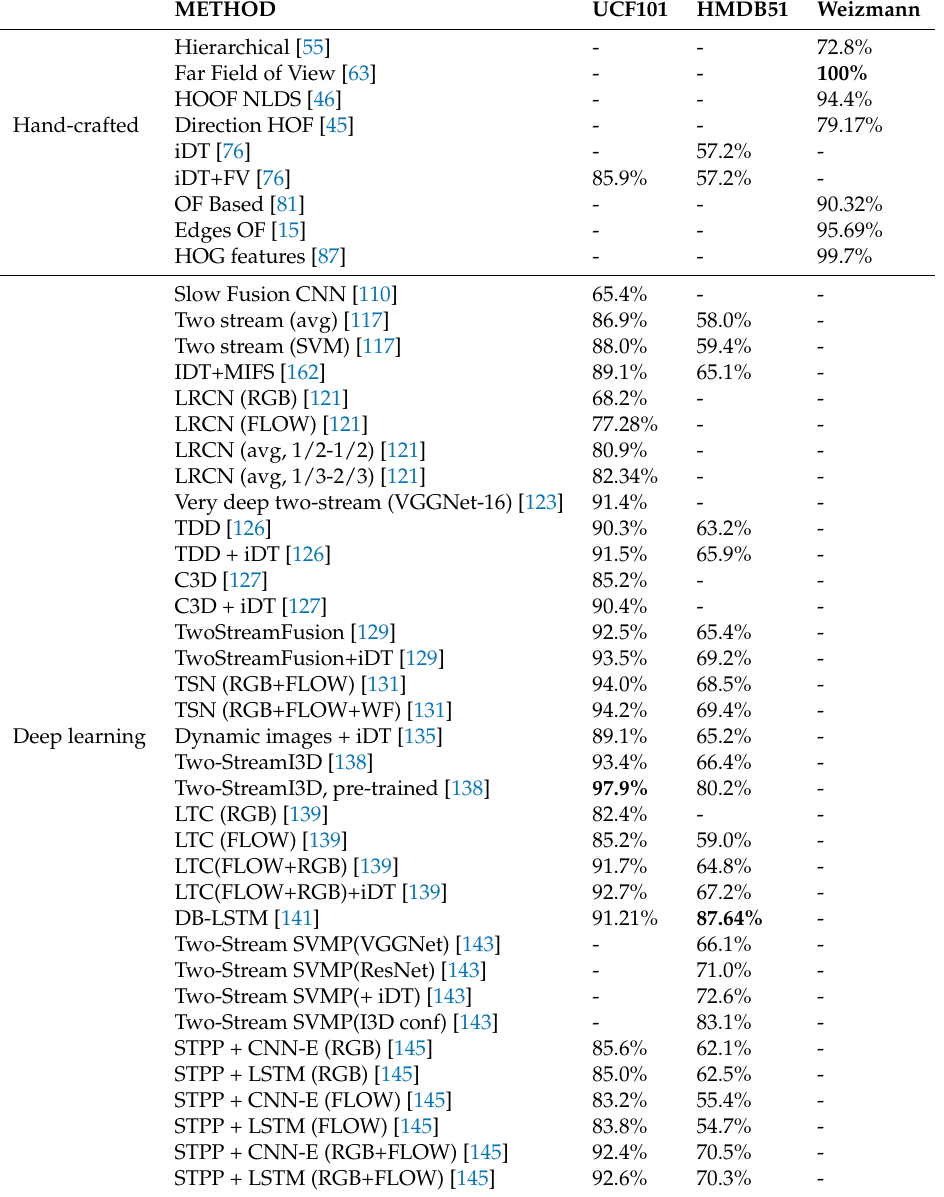
Table 7. Obtained accuracies for the benchmark datasets with hand-crafted methods and deep learning